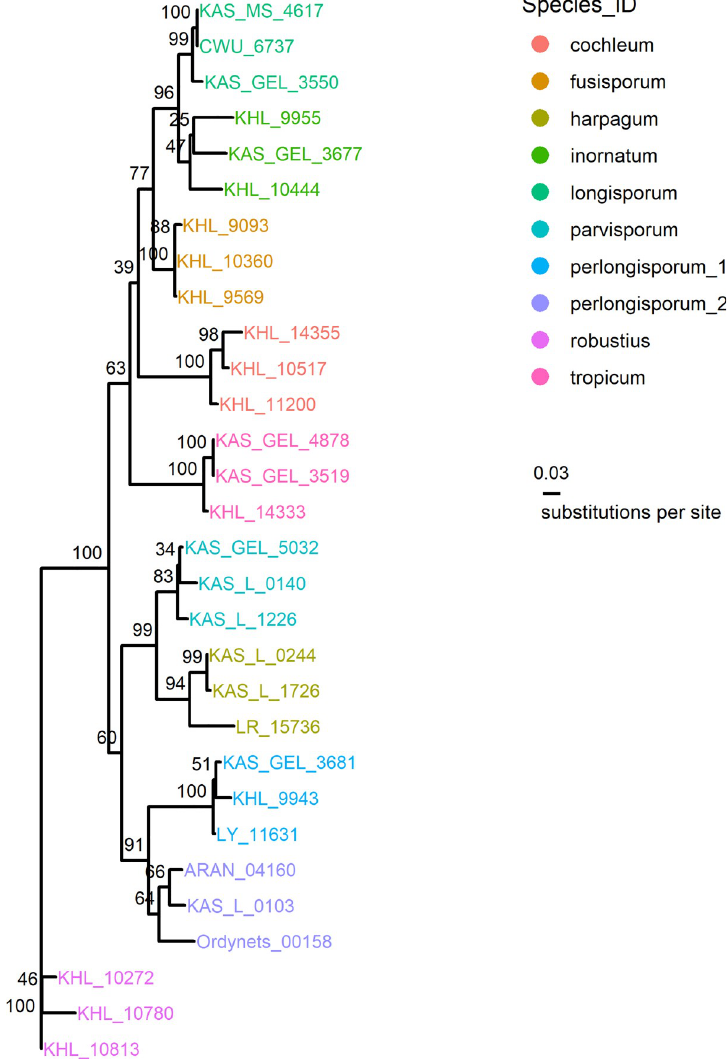
Fig 3. Phylogenetic analysis resolves 10 Subulicystidium species as monophyletic and thus suitable for discriminant